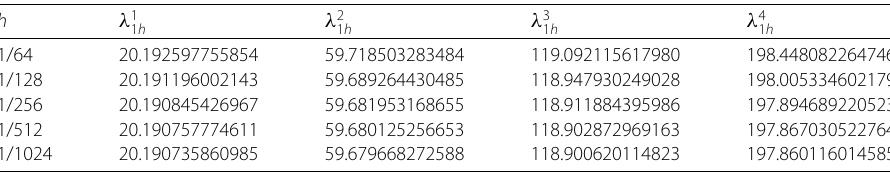
Table 2 a = 0, the four eigenvalues with l = 1 and h h